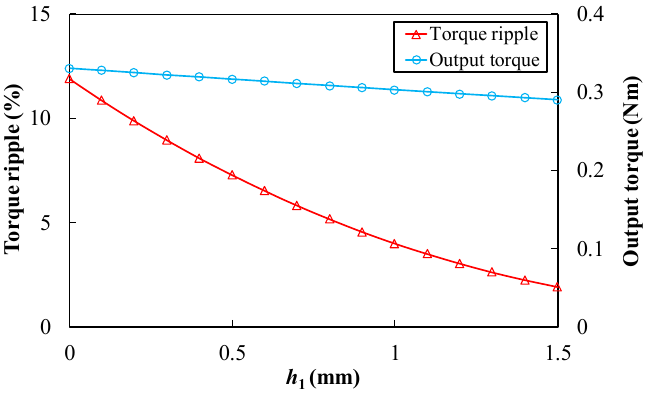
Figure 3. Torque characteristics vs. h 1 .